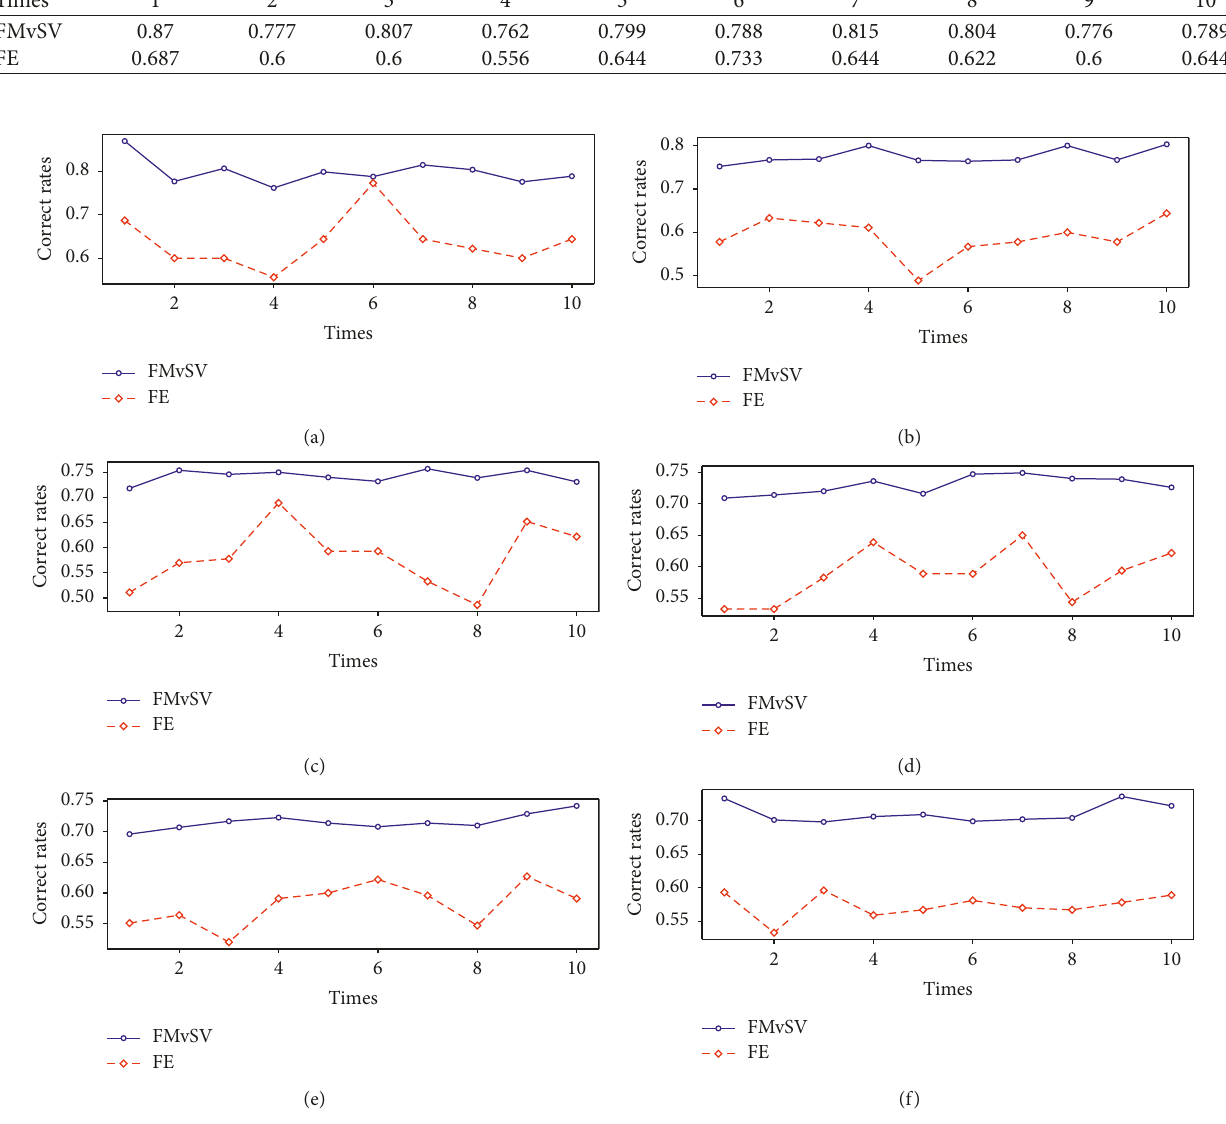
Figure 4 reflects the following facts: (i) When the data size increases under the same missing